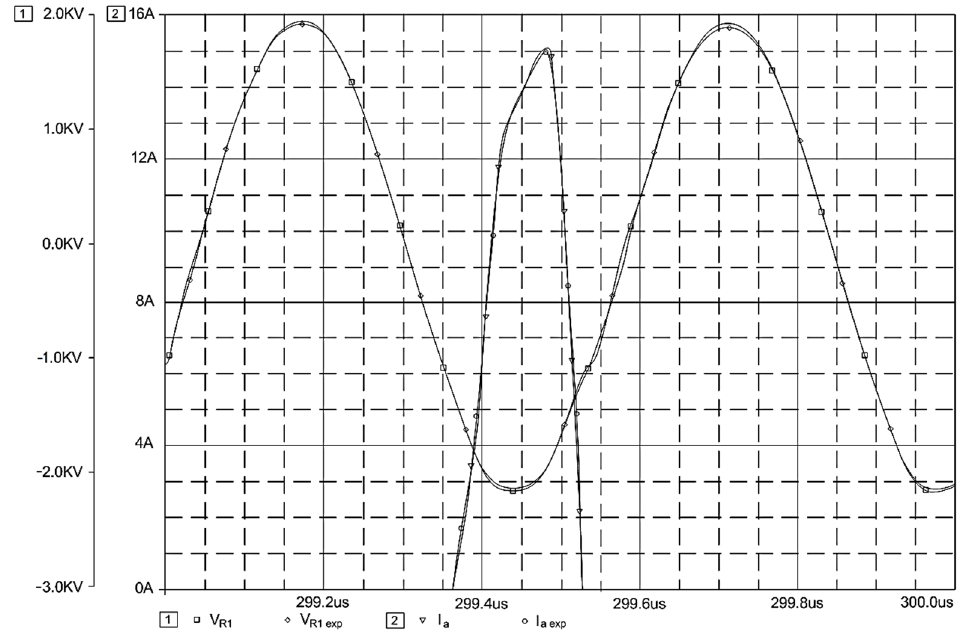
Figure 8. Results of the measurement and simulation for the consumer voltage and the anode current.